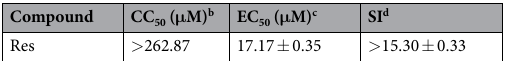
Table 1. Inhibition effects of Res on PRV in vitro a . a The inhibition effects on PRV were evaluated by CCK-8 assay. b Effective concentration 50% (EC50): concentration required to inhibit PRV at 48 h post-infection by 50% (n = 6). c Cytotoxic concentration 50% (CC50): concentration required to reduce cell viability by 50% (n = 6). d SI: the selectivity index is defined as the ratio of CC 50 to EC 50